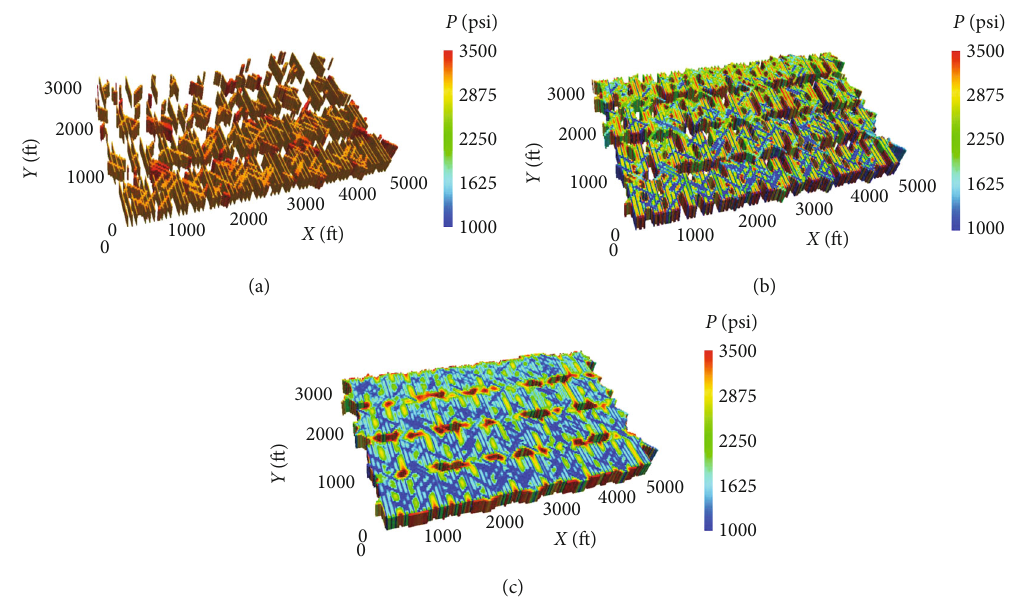
Figure 17: Drainage volume for the optimal well spacing scenario: (a) after 1 year, (b) after 5 years, and (c) after 20